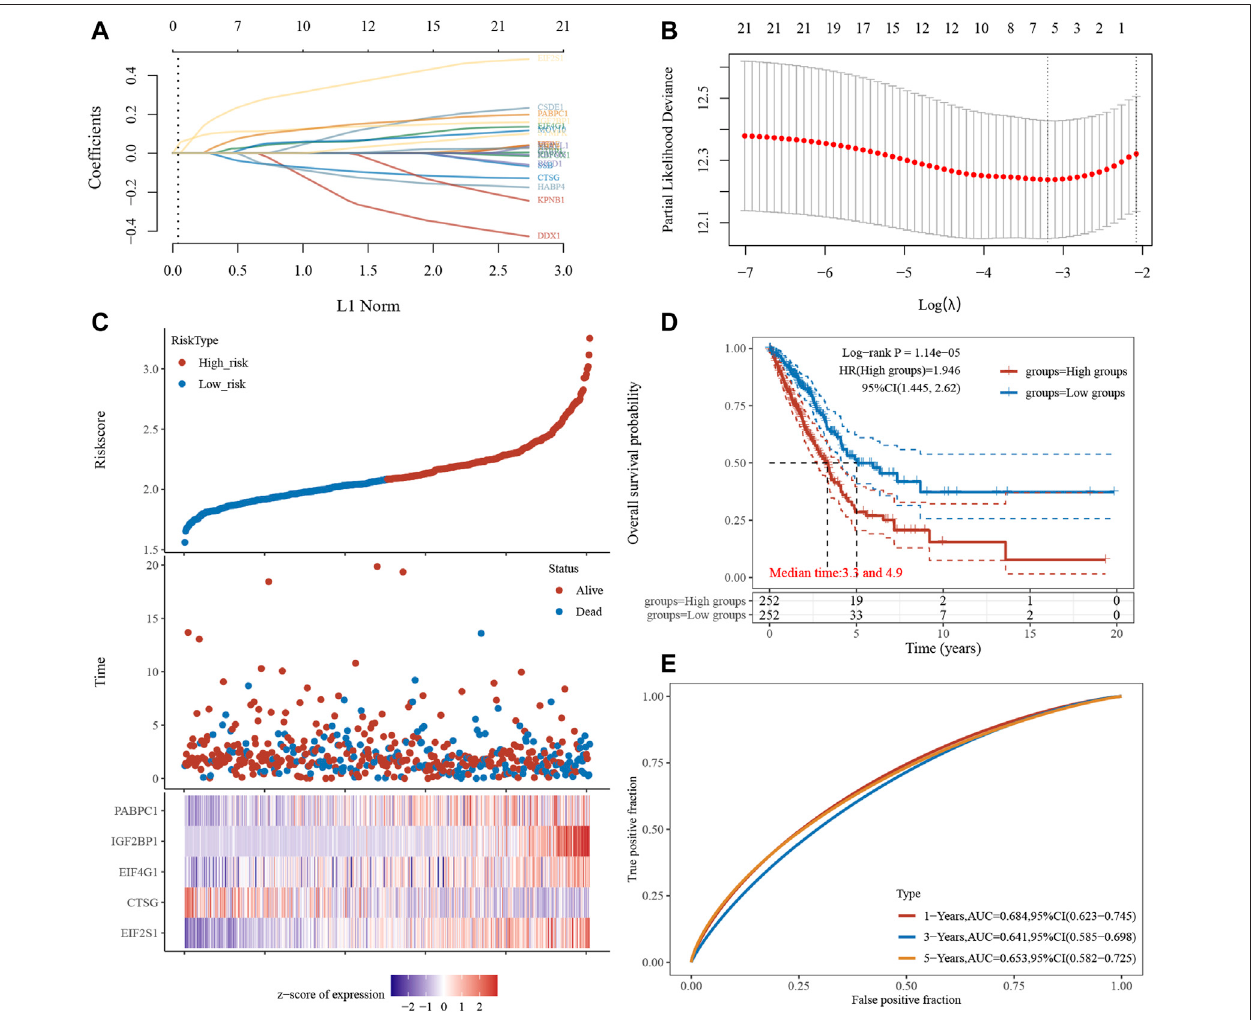
FIGURE 11 | Risk Model Construction and Stress Granule Score. (A) LASSO coef fi cients pro fi les of Stress Granule regulators. (B) LASSO regression with tenfold cross-validation obtained fi ve prognostic genes using minimum lambda value. (C) Individual patients with NSCLC had their stress granule levels quanti fi ed using the StressGranulescore,whichtookintoaccounttheindividualvariabilityandcomplexityofgeneexpression levels. (D) Kaplan-Meiersurvivalanalysisshowedpatientswith low stress granule scores had a signi fi cant survival advantage. (E) ROC curve analysis of the Stress Granule risk model in NSCLC.